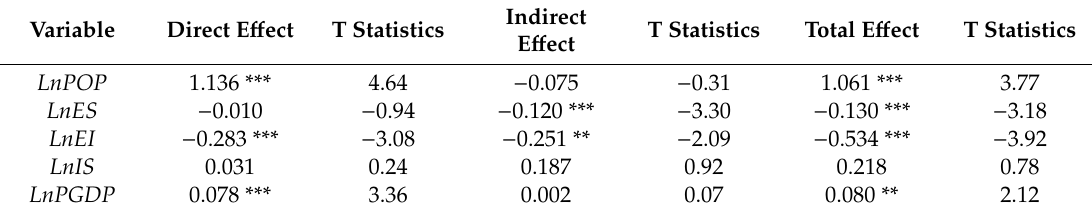
Table 7. Direct, indirect and total e ff ects for the EGI